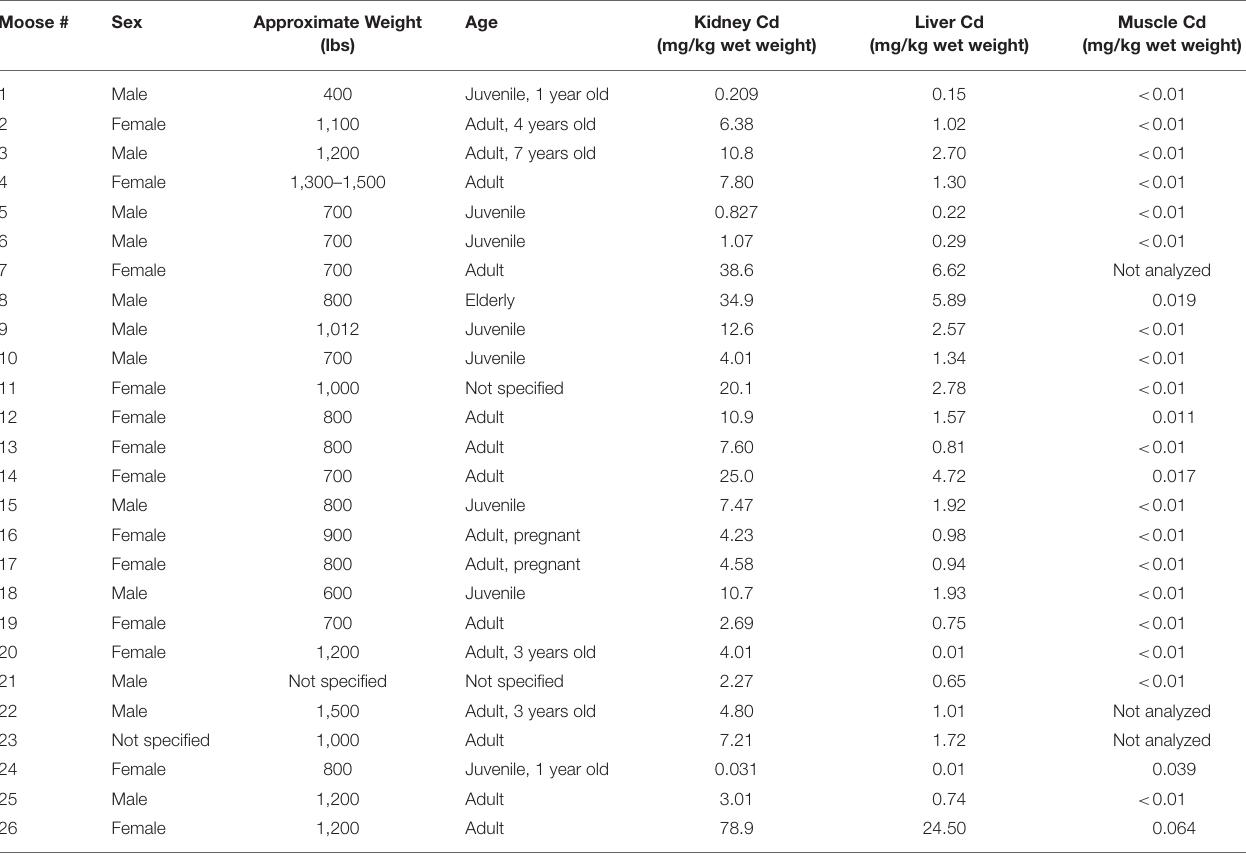
TABLE 2 | CPDFN Moose Details (sex, age, weight, and tissue concentrations).